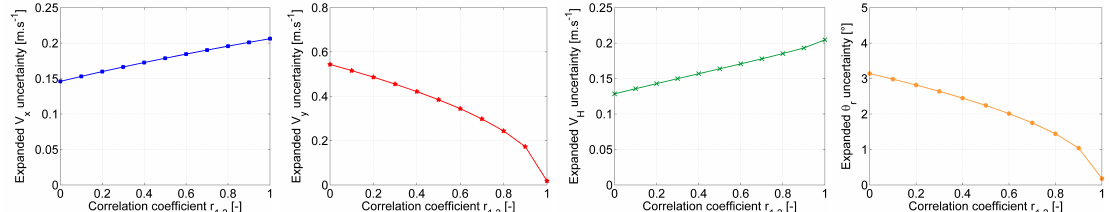
Figure 12. Expanded uncertainties U V